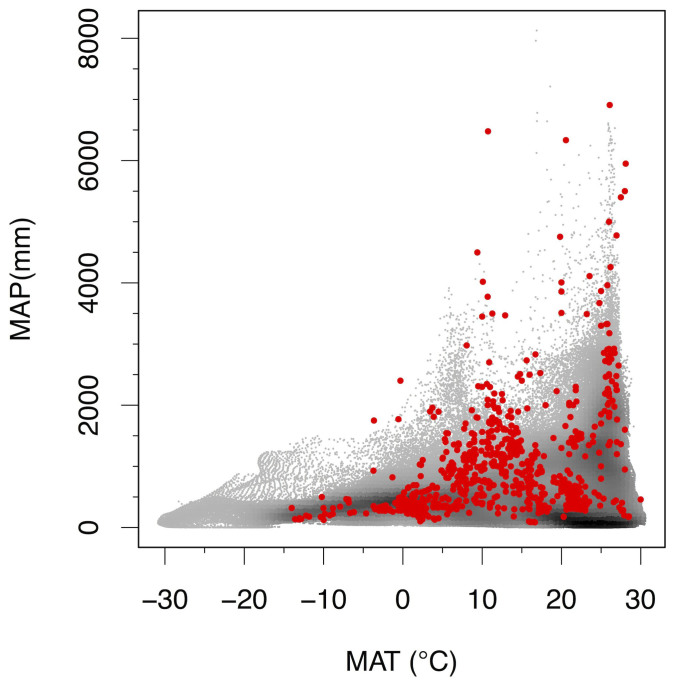
Map of climate space of sites in this study to global terrestrial climate density.Sites used in this study are red. Background points represent the density of ice-free land surface area at particular combinations of mean annual temperature (MAT) and mean annual precipitation (MAP).